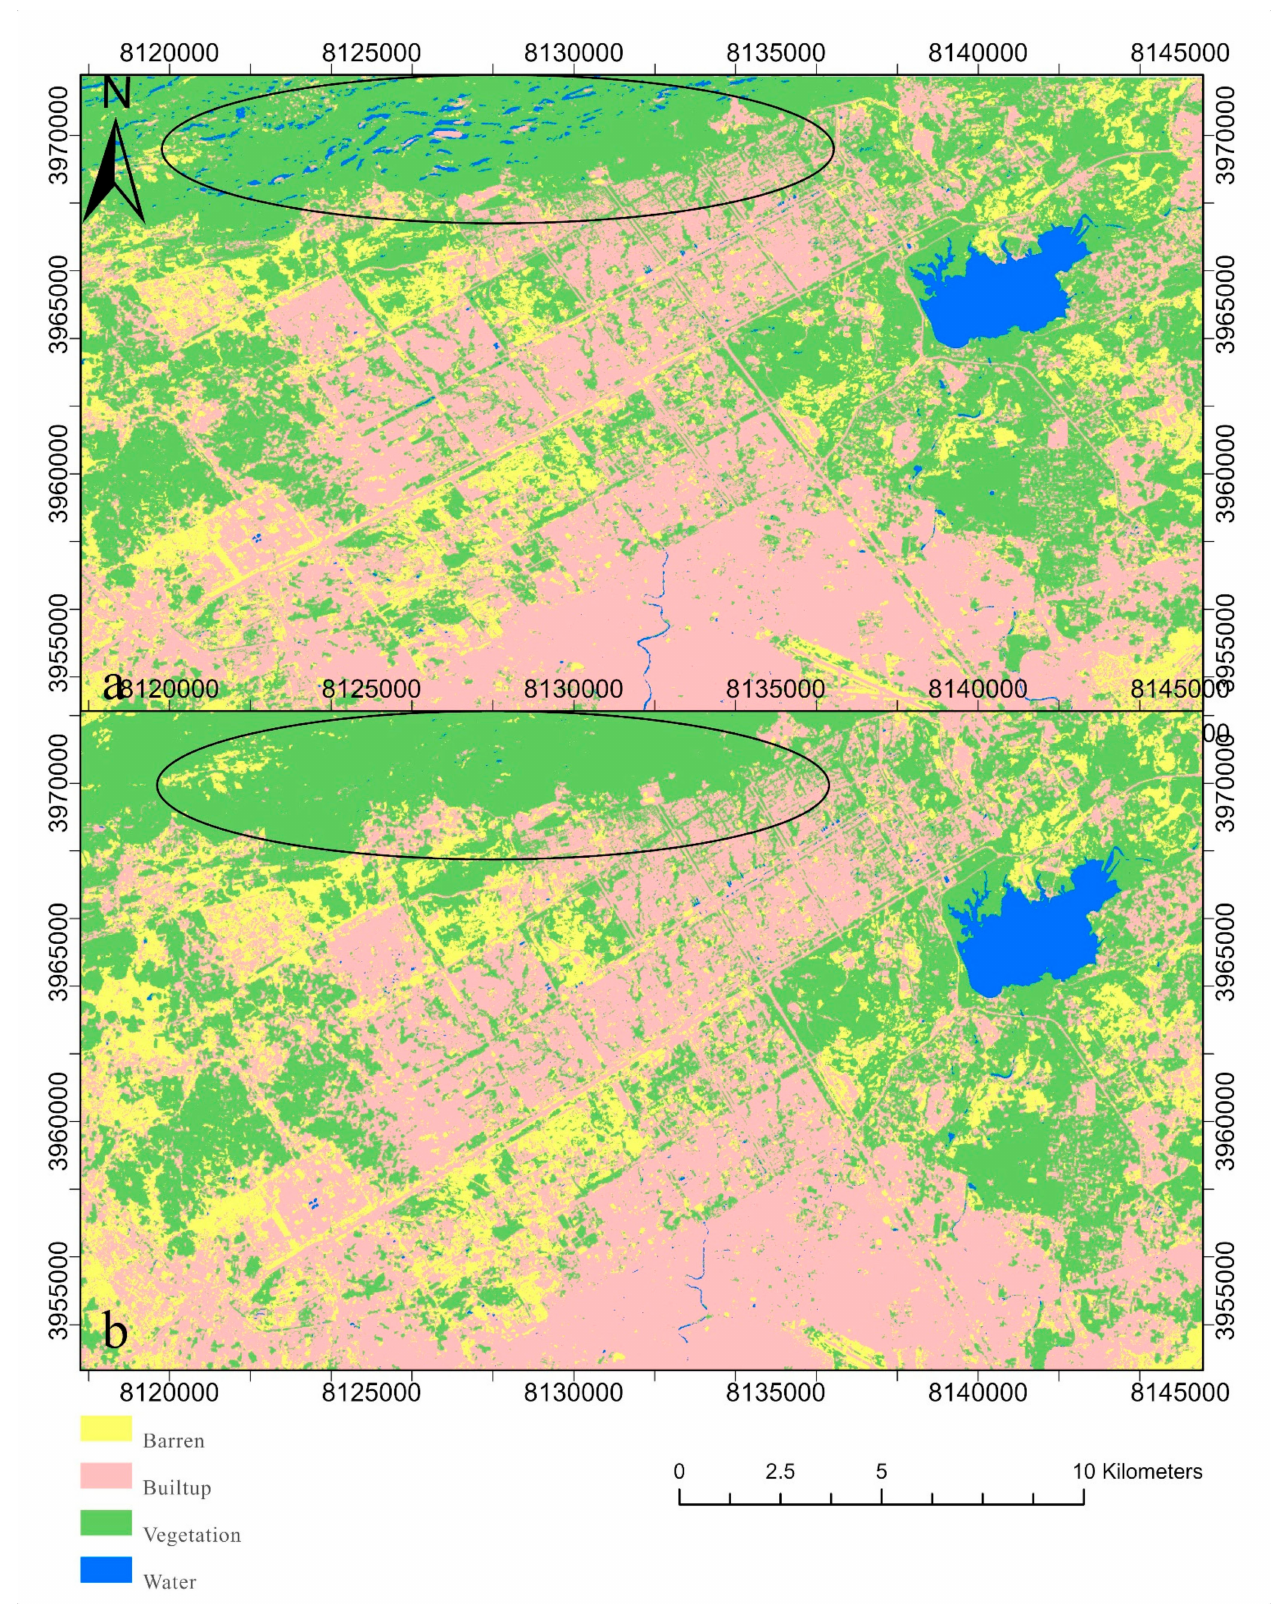
Figure 6. Land cover maps of Rawalpindi from ( a ) optical data and ( b ) fusion data demonstrating misclassified hill topography into water. Misclassifications are in figure ( a